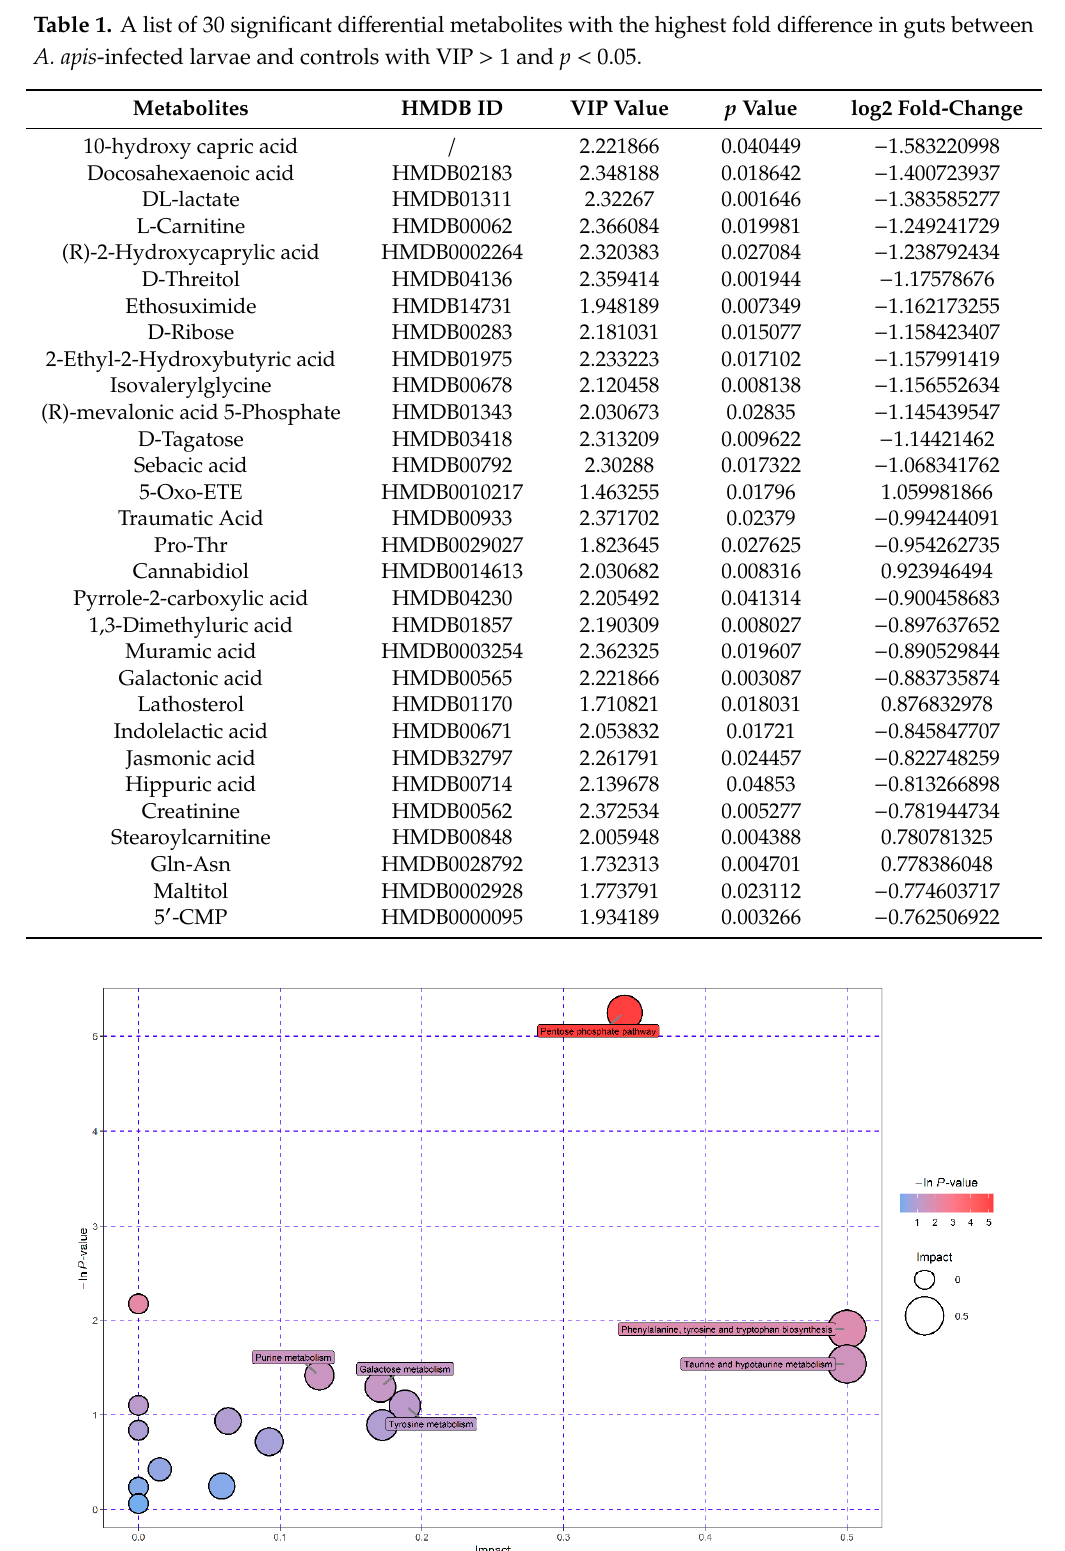
Figure 4. The bubble plot displays significant metabolic pathways of the mapped differential metabolites between A. apis -infected larvae and controls. Pathway impact score is proportional to the bubble size, and significance level of the pathway is denoted by the bubble color, ranging from highest (red) to lowest (blue).